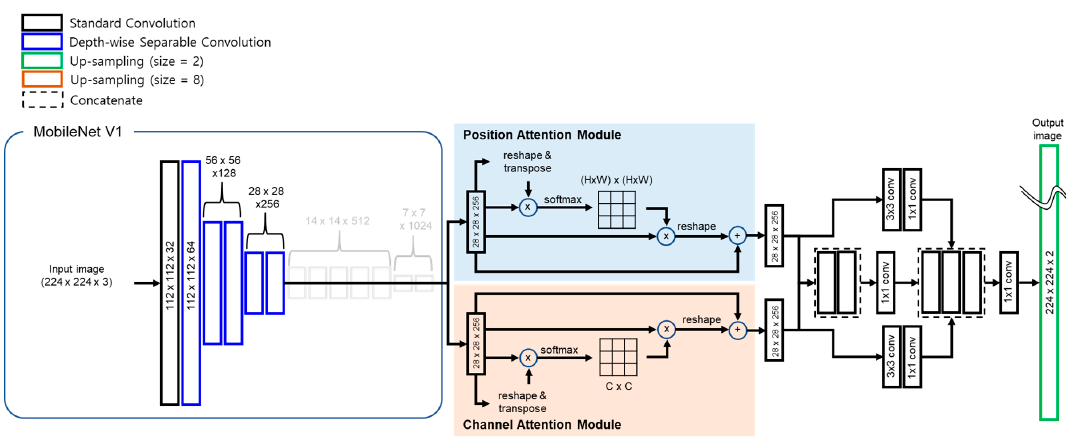
Appl. Sci. 2023 , 13 , 2367 Figure 5. Model architecture of DeepLabV3Plus. Figure 5. Model architecture of DeepLabV3Plus. Figure 5. Model architecture of DeepLabV3Plus.